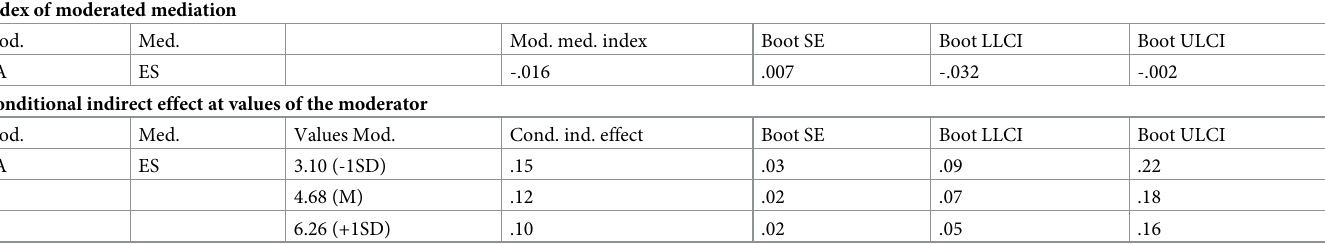
Table 4. Moderated mediation analysis of the indirect effect of the negative perceptions of wearing face masks on tourist’s intentions to visit nature-based resorts through the perceived need for escapism. Index of moderated